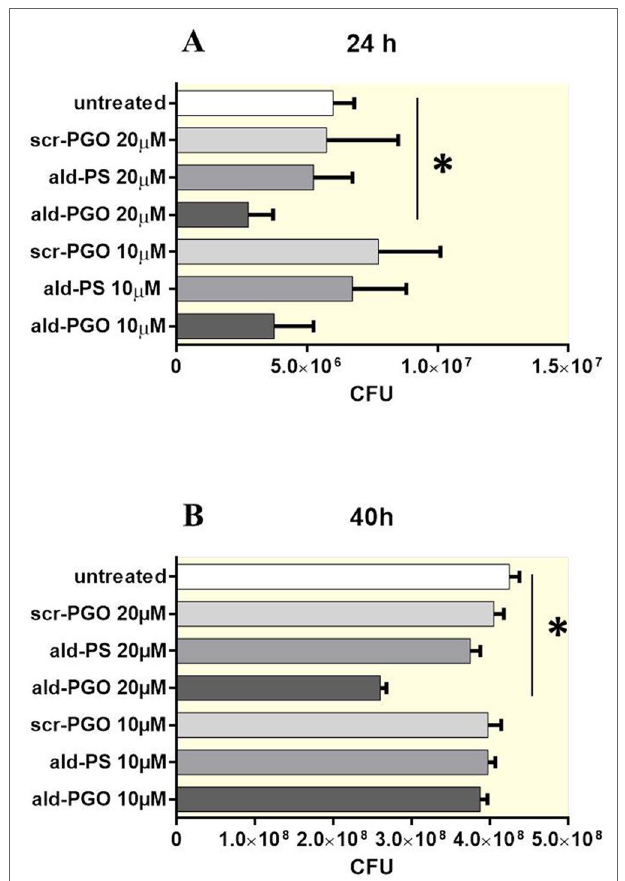
FIGURE 2 | Growth of Mycobacterium smegmatis cultures in the presence of different ASOs at different time points after ASO treatment: 24 h (A) and 40 h (B) . Mycobacteria were treated with 10 and 20 μM of ald -PGO, ald -PS, and scr-PGO, or left untreated for the indicated times. The data are presented as the mean ± SD of three independent experiments; * p < 0.05. ASOs, antisense